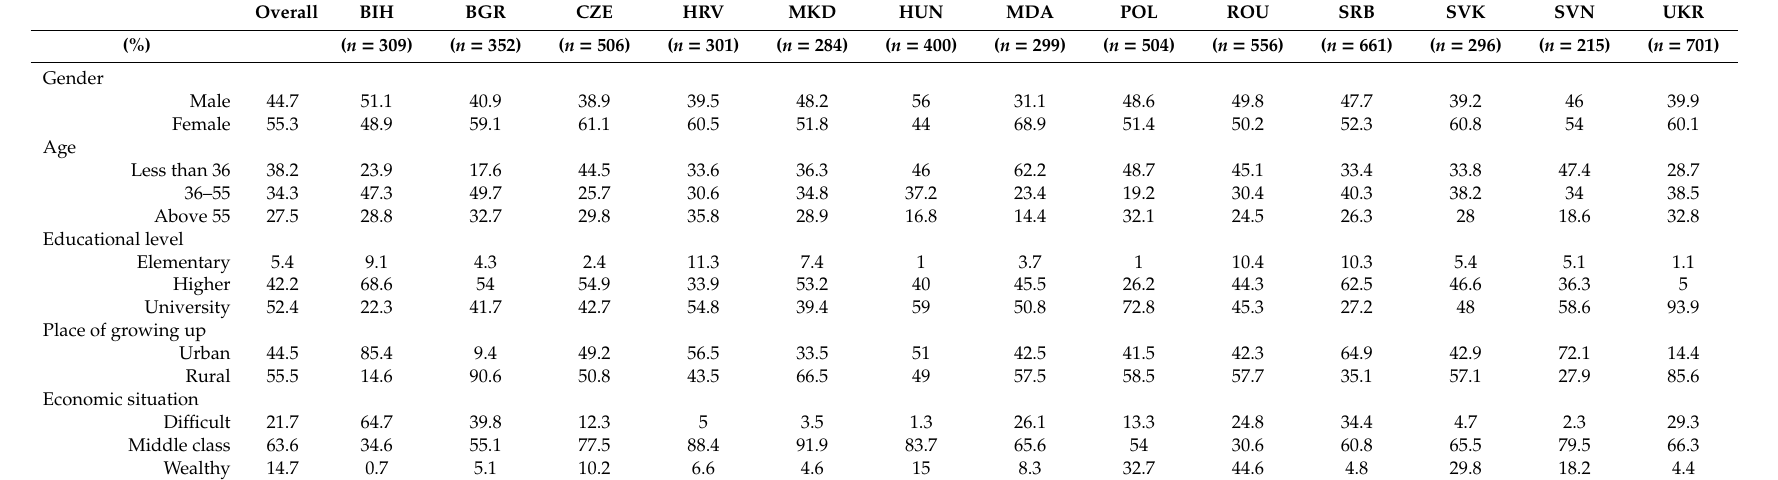
Table 1. Demographic profile (%) of the sample of consumers that participate in the study by country 1 ( n =